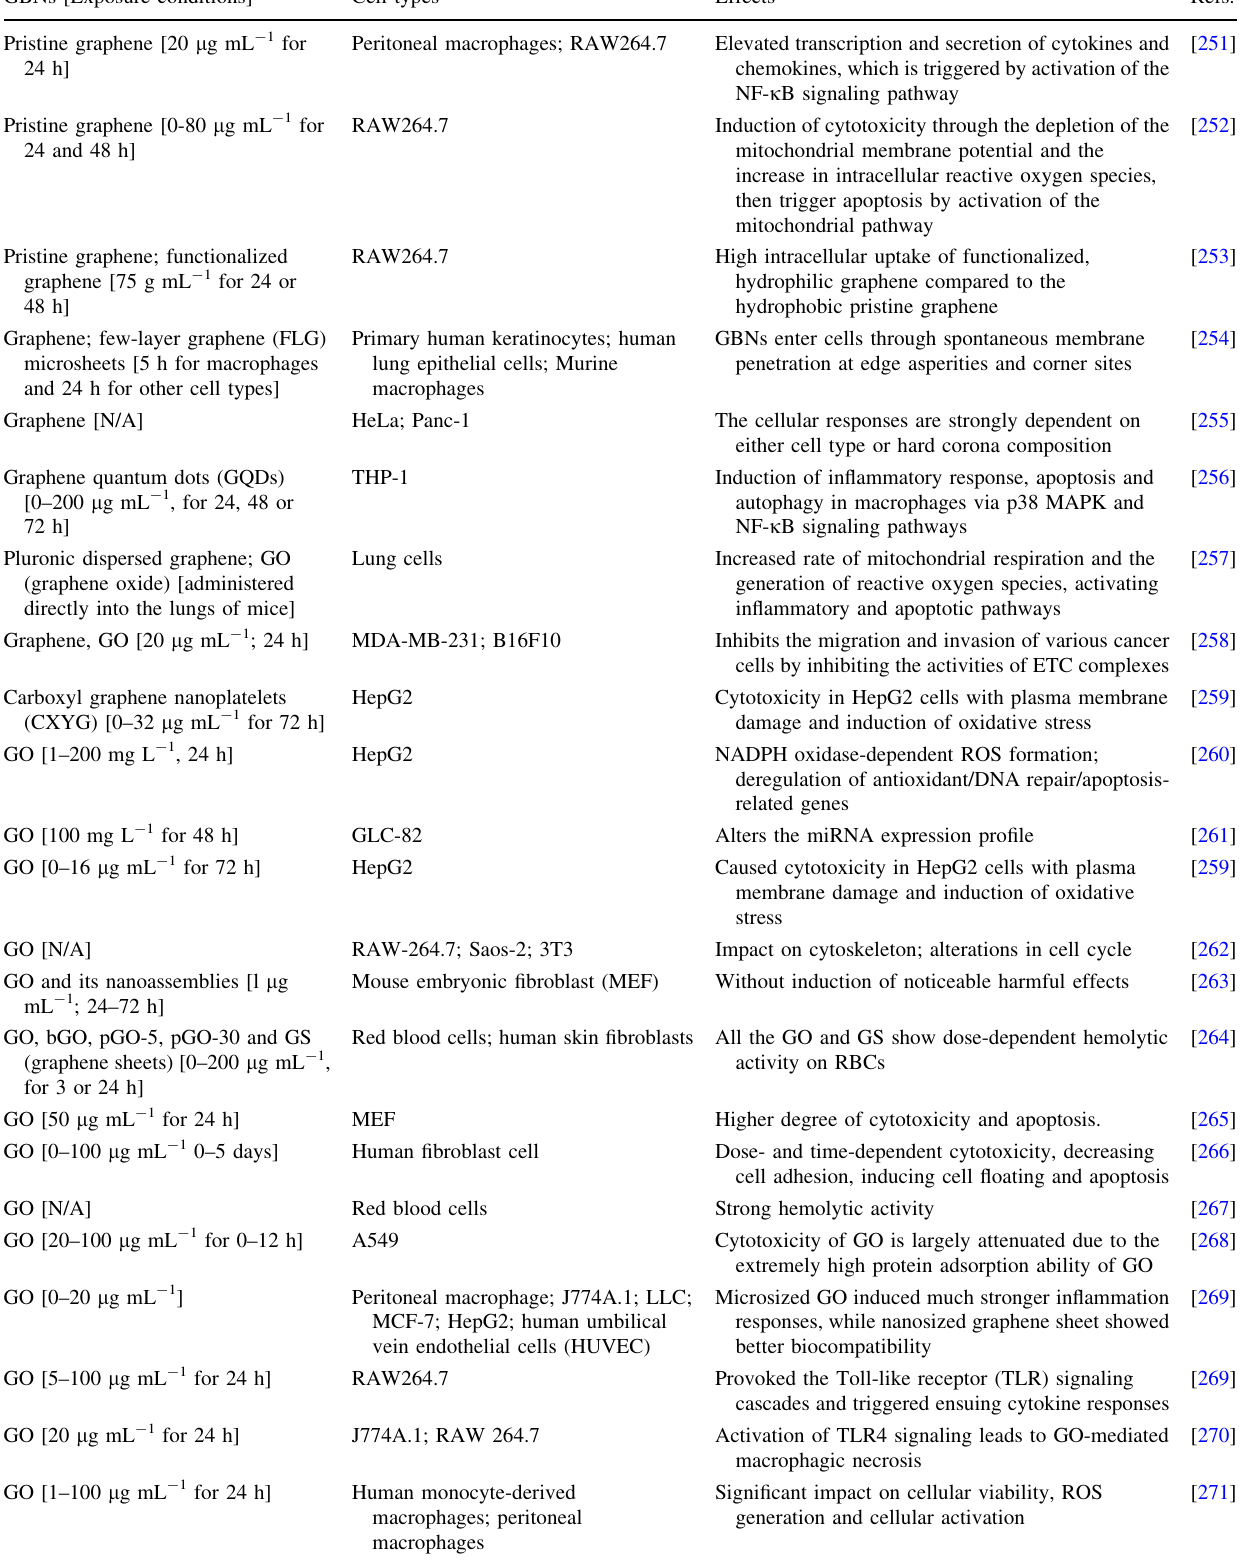
Table 5 GBNs toxicity effects in various cells (data adapted from Ref. [152]). Copyright (cid:2) Elsevier